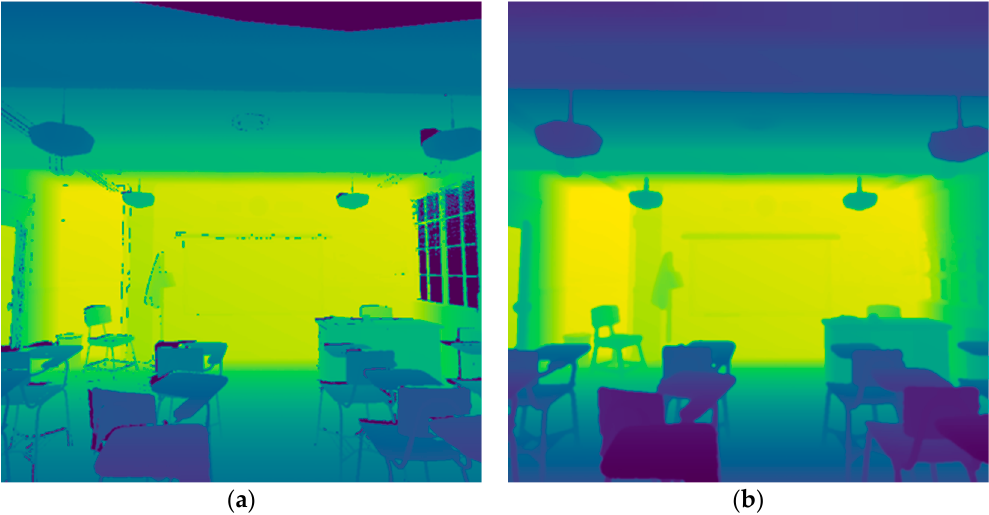
Figure 6. ( a ) Depth data with holes in a new perspective. ( b ) Depth recovery using complementary algorithm.